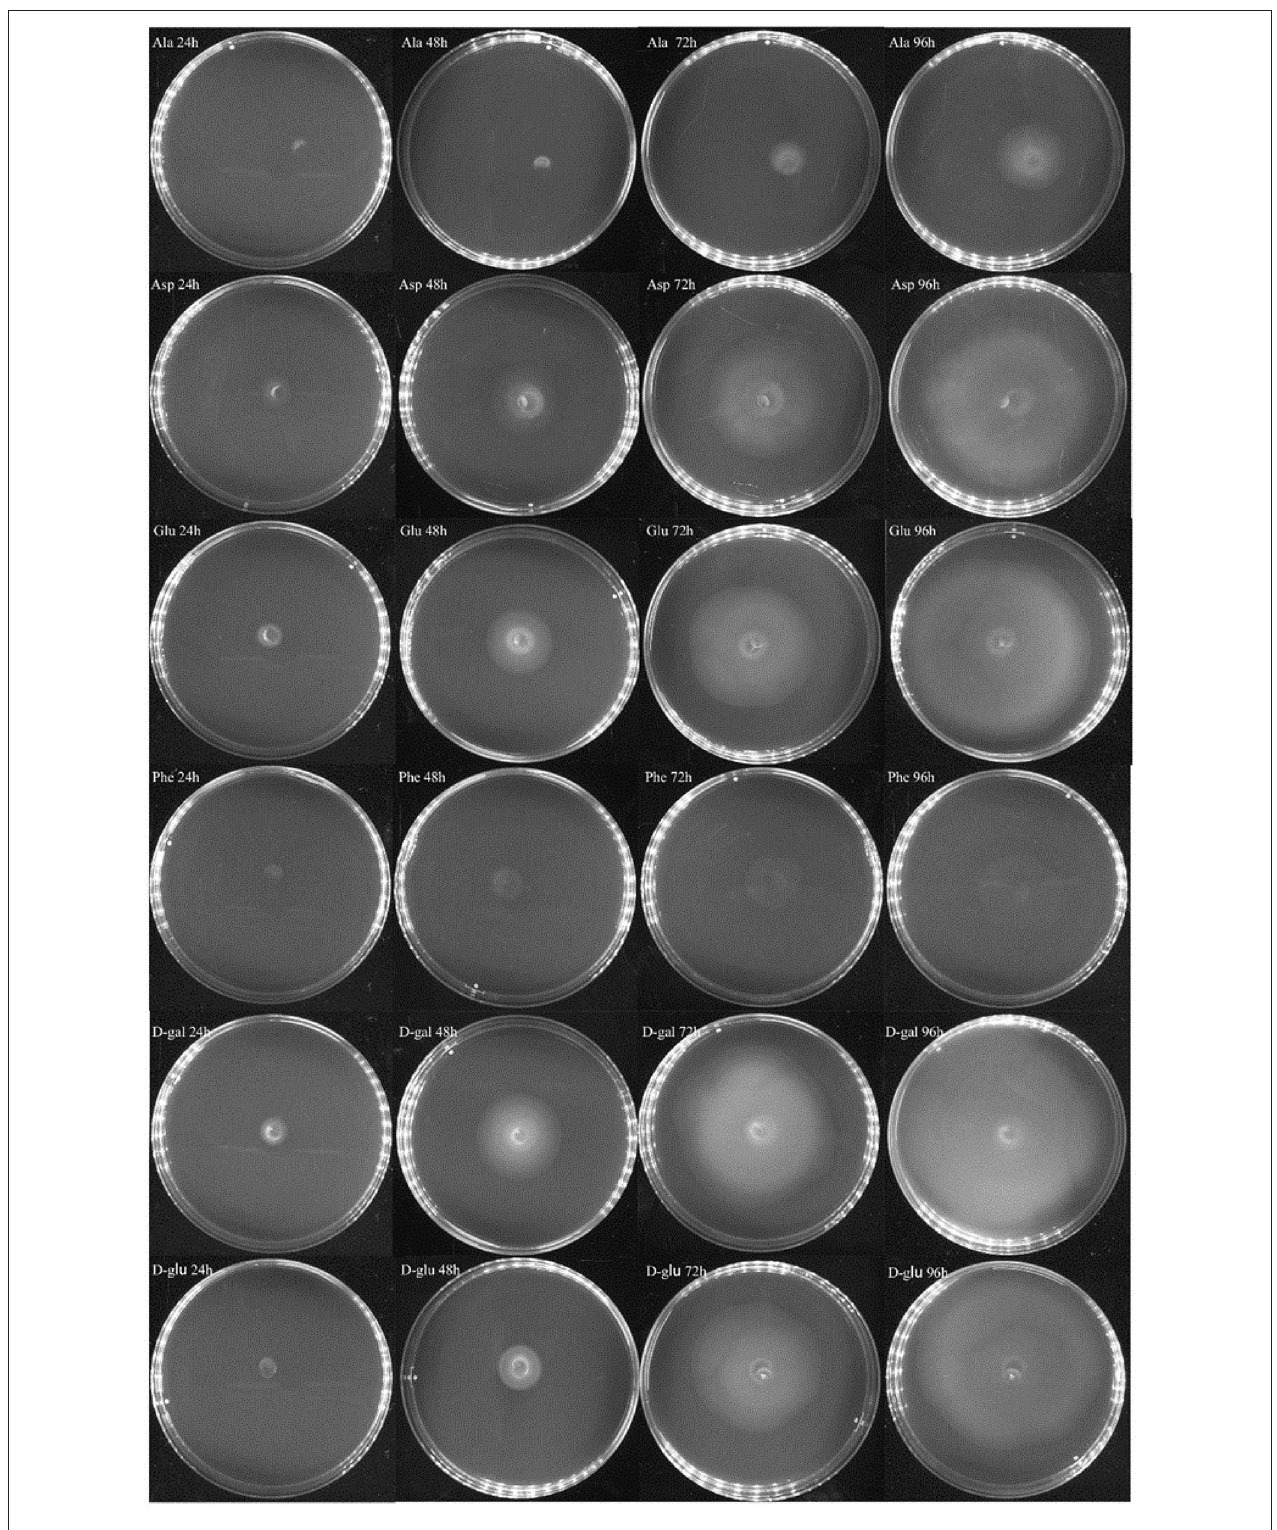
FIGURE 6 | Chemotaxis of V. splendidus exponential cells. Each exogenous carbon source at a concentration of 400 mg · L − 1 was separately added into M9 minimal plates containing 0.20% (w/v) agar; 1ml M9 minimal medium was used to resuspend persister cells, and 10 µ l cell suspensions was dropped on the M9 minimal plate containing each carbon source, and the plates were incubated at 28 ◦ C for